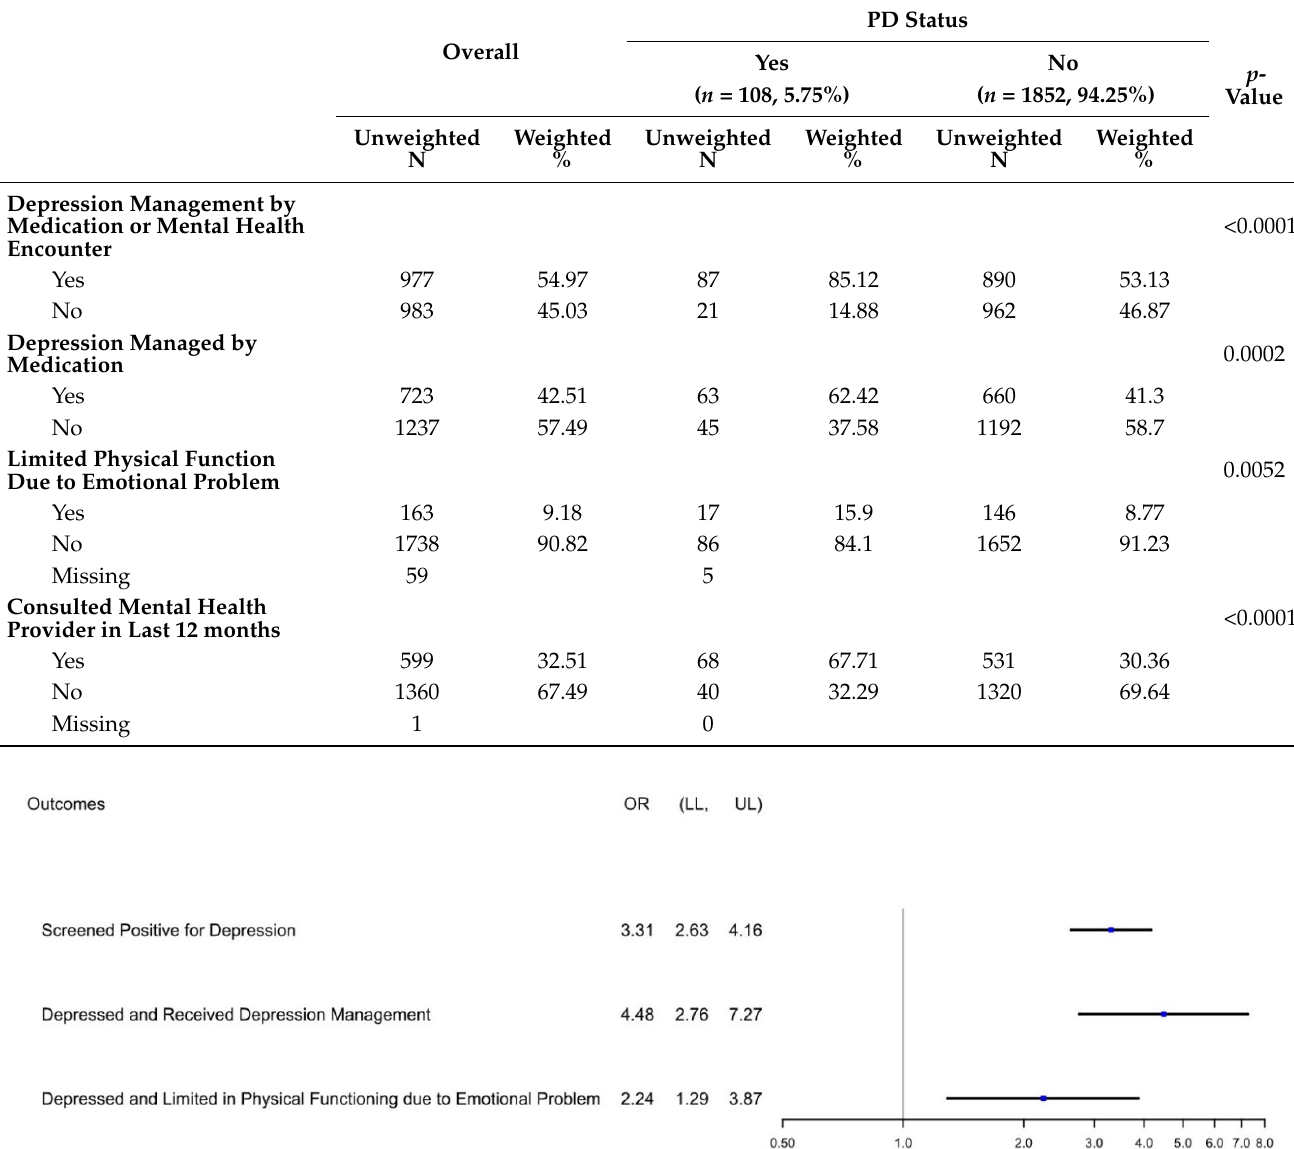
Table 3. Treatment of Depression in Individuals Screening Positive for Depression (PHQ-9 ≥ 10).